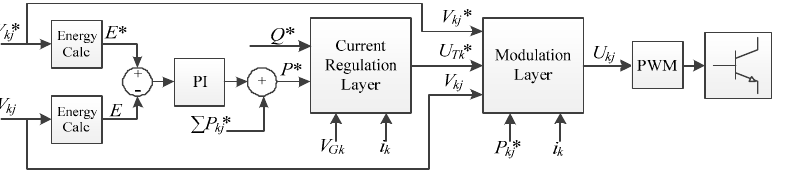
Figure 3. General control scheme. The proposed method as well as the state-of-the-art alternative belong in the modulation layer.